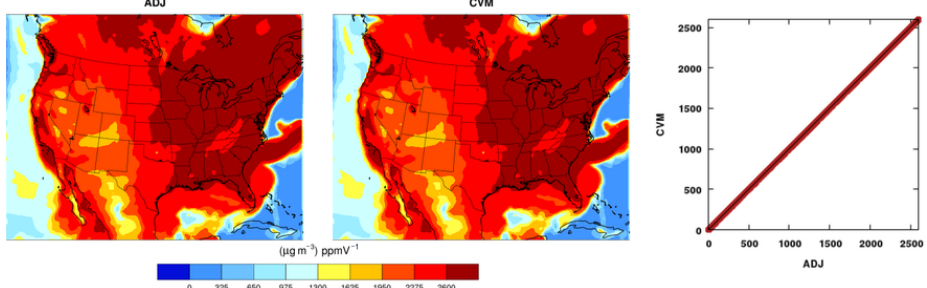
Figure 1. Evaluation of the SOA (secondary organic aerosol) process with the ADJ (adjoint) against the CVM (complex variable method) sensitivities of the final concentrations of an accumulation-mode aerosol species AALKJ (µgm − 3 ) with respect to the initial concentrations of a semi-volatile species SV_ALK (ppmV) from a 1d test run. The perturbation size for the CVM is 1.E-24.